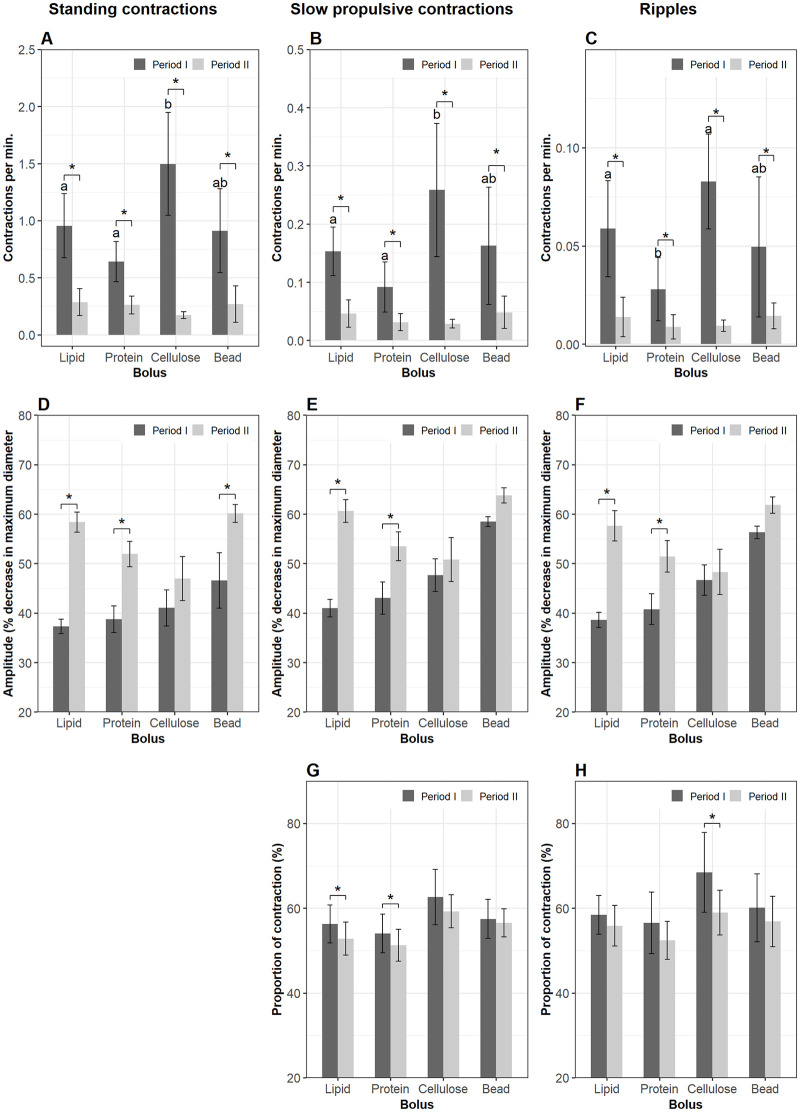
Motility parameters in Segment 1 (the bulbous).Contractions were analyzed in Segment 1 of the intestines when a bolus (lipid, protein, cellulose or plastic bead) was administered into the lumen (period I) and after the bolus left (period II) this segment. Frequency (mean±s.d.) of standing contractions (A), slow propulsive contractions (B) and ripples (C). Amplitude (median±s.e.m.) of standing contractions (D), slow propulsive contractions (E) and ripples (F). Proportion (mean±s.d.) of slow propulsive contractions (G) and ripples (H) which propagate to an anterograde direction. Significant differences (p < 0.05) between the four bolus treatments within period I are annotated by Latin letters and no differences within period II. Asterisks and brackets show a significant difference (p < 0.05) between periods. Data were analyzed using linear mixed-effects models—lme test followed by Tukey HSD in R for (A–C); Generalized Linear Mixed Models via PQL—glmmPQL test for (D–H), with n = 11 for lipid, n = 12 for protein, n = 6 for cellulose or plastic bead.